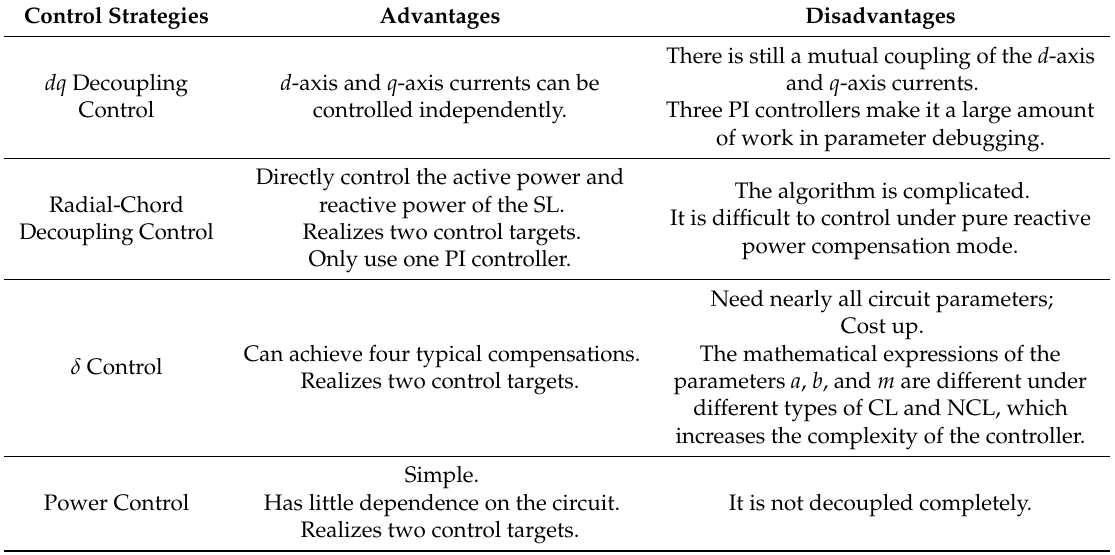
Table 1. Comparisons between Existing Typical Control Strategies of